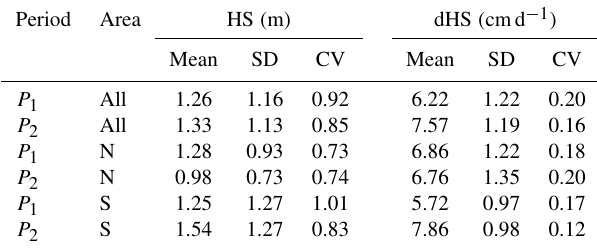
Table 2. The mean, standard deviation (SD) and coefficient of vari- ation (CV) for snow depth (HS) and snow depth change (dHS) for different periods and areas. P 1 was from 19 May to 1 June 2015 and P 2 was from 1 June to 24 June 2015. Values are only given for snow-covered areas. Values for HS are given for the start date of the period. Values for dHS are given for the area that was snow covered at the end of the melt